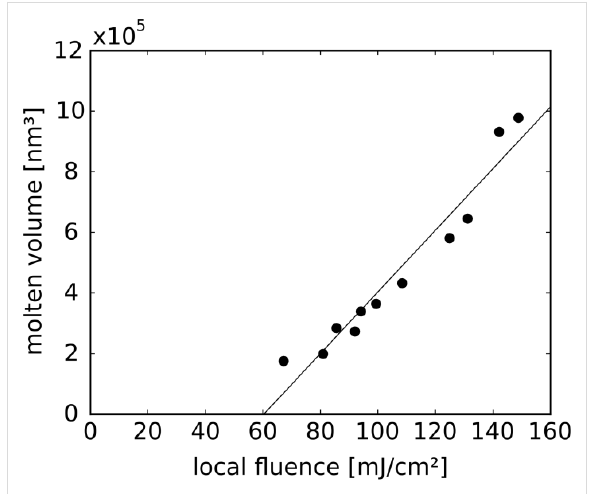
Figure 16: Molten volume at the triangle tips vs local laser